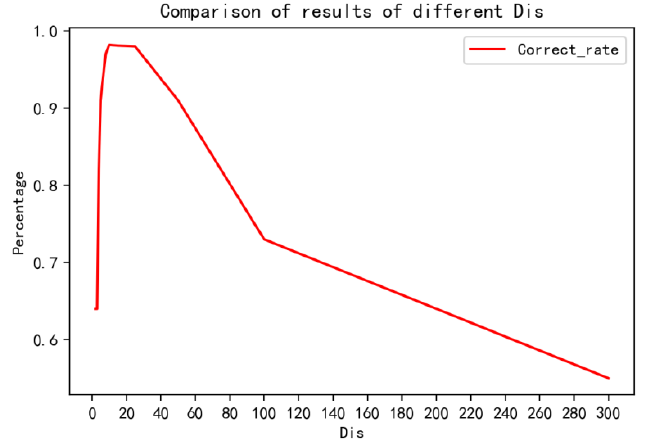
Figure 9. Comparison of detection statistics with different Dis values.